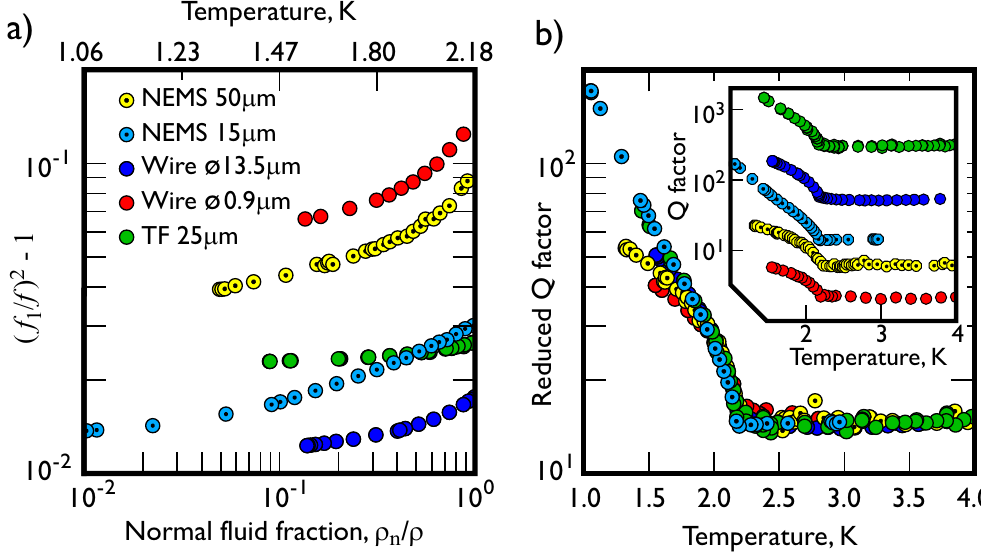
Figure 3. A comparison of the frequency response of the NEMS oscillators with superconducting NbTi vibrating wires 41, 42 and a quartz tuning “space” fork 43 operated in the superfluid. ( a ) The frequency shift as a function of temperature. The lightness and small geometrical sizes of the NEMS resonators give a higher sensitivity to the normal fluid component of the 4 He than the other commonly used beam-like devices. ( b ) Temperature dependence of the reduced Q-factor for various beam-like resonators. The response of the NEMS devices in the liquid is similar to that of the other devices and promises excellent prospects for their use as detectors in quantum fluids. Inset : The temperature dependencies of the Q -factors for all resonators around the superfluid transition. Since the Q -factors are determined by the conventional Stokes ′ drag, they are almost independent of temperature above the lambda-point transition T λ = 2.178 K, but begin to increase significantly with the reduction of the temperature below T λ from the reduction in the density of the normal